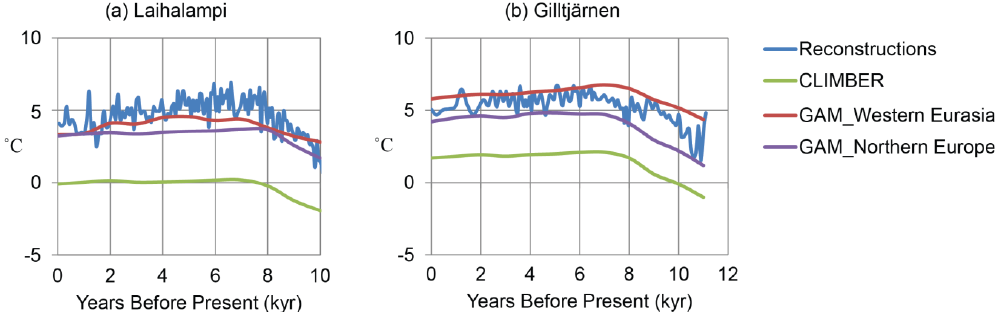
Figure 6. Comparison of simulation data and pollen-based reconstructions of annual mean temperatures from (a) Laihalampi in Fin- land and (b) Gilltjärnen in Sweden. The blue curves represent reconstructions by Heikkilä and Seppä (2003) for Laihalampi, and by Antonsson et al. (2006) for Gilltjärnen. The green contours are interpolations from CLIMBER-2 simulations by Ganopolski et al. (2010). The GAM_Western Eurasia (red curves) and GAM_Northern Europe (purple curves) data were downscaled by GAM models from the CLIMBER-2 data in this